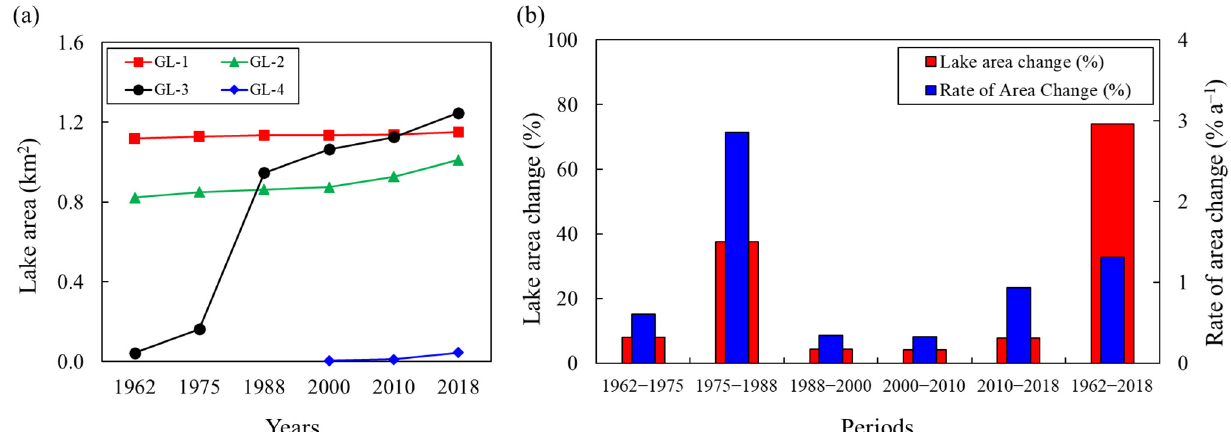
Figure 5. Gurudongmar lake complex area change from 1962 to 2018: ( a ) Individual lake area change (km 2 ); and ( b ) Temporal dynamics in the total area change (%) and rate of area change (% a − 1 ).